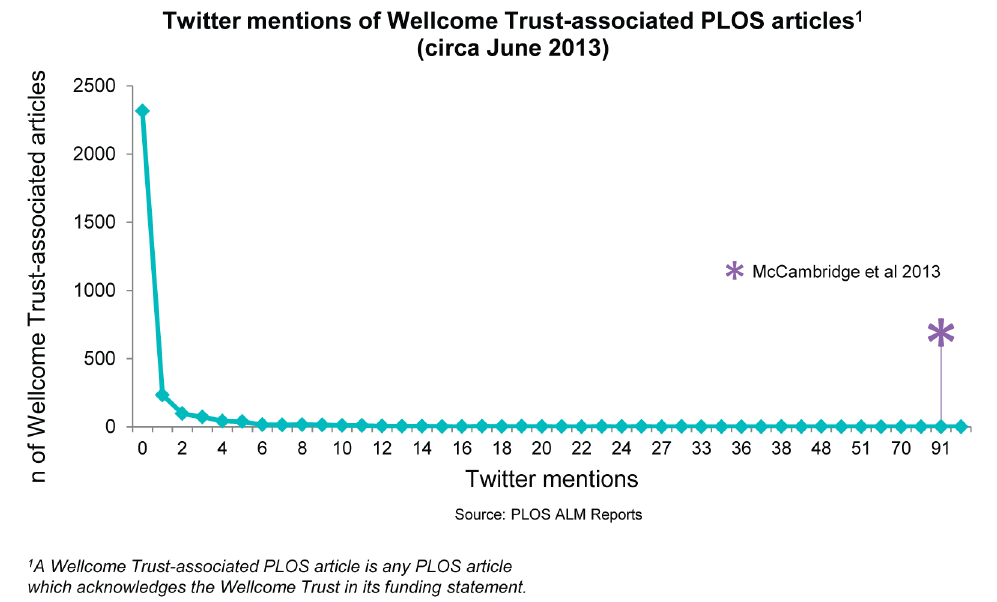
Figure 1. Tweets discussing Wellcome Trust-associated PLOS articles c. June 2013.